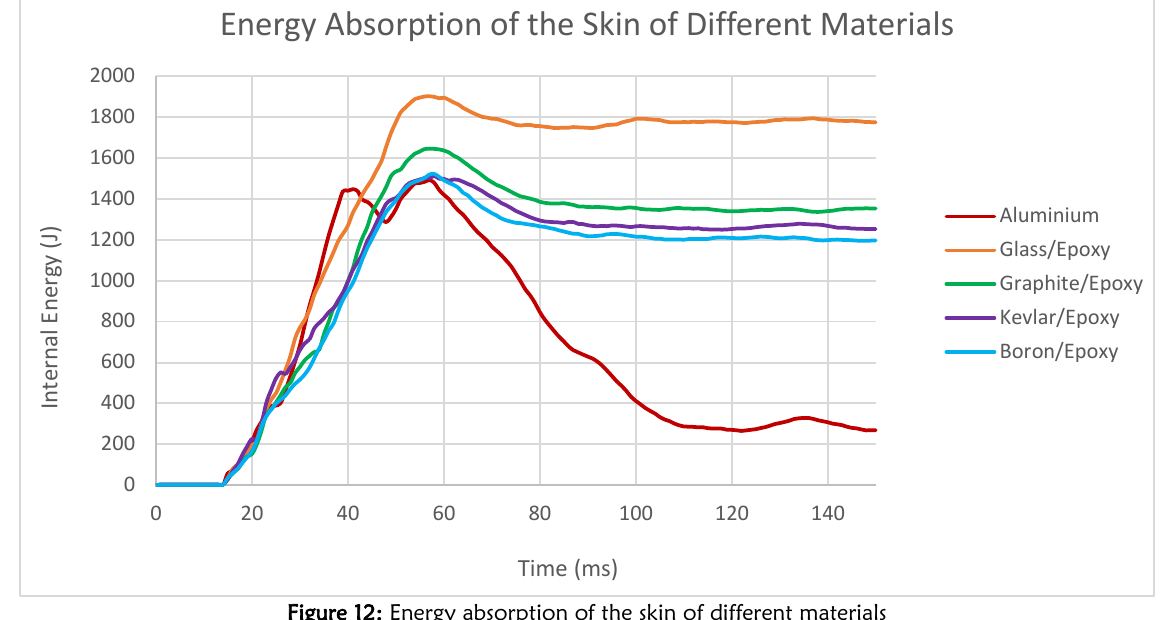
Figure 12: Energy absorption of the skin of different materials